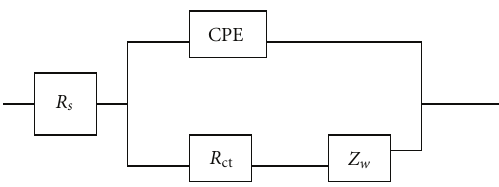
Figure 14: Proposed equivalent circuit for the methanol oxidation on Pt-Pd/C catalyst in a solution containing 0.5MNaOH and 1.0M methanol at 140 mV. ( R s : solution resistance CPE: constant phase element R ct : Charge transfer resistance, and Z w : warburg